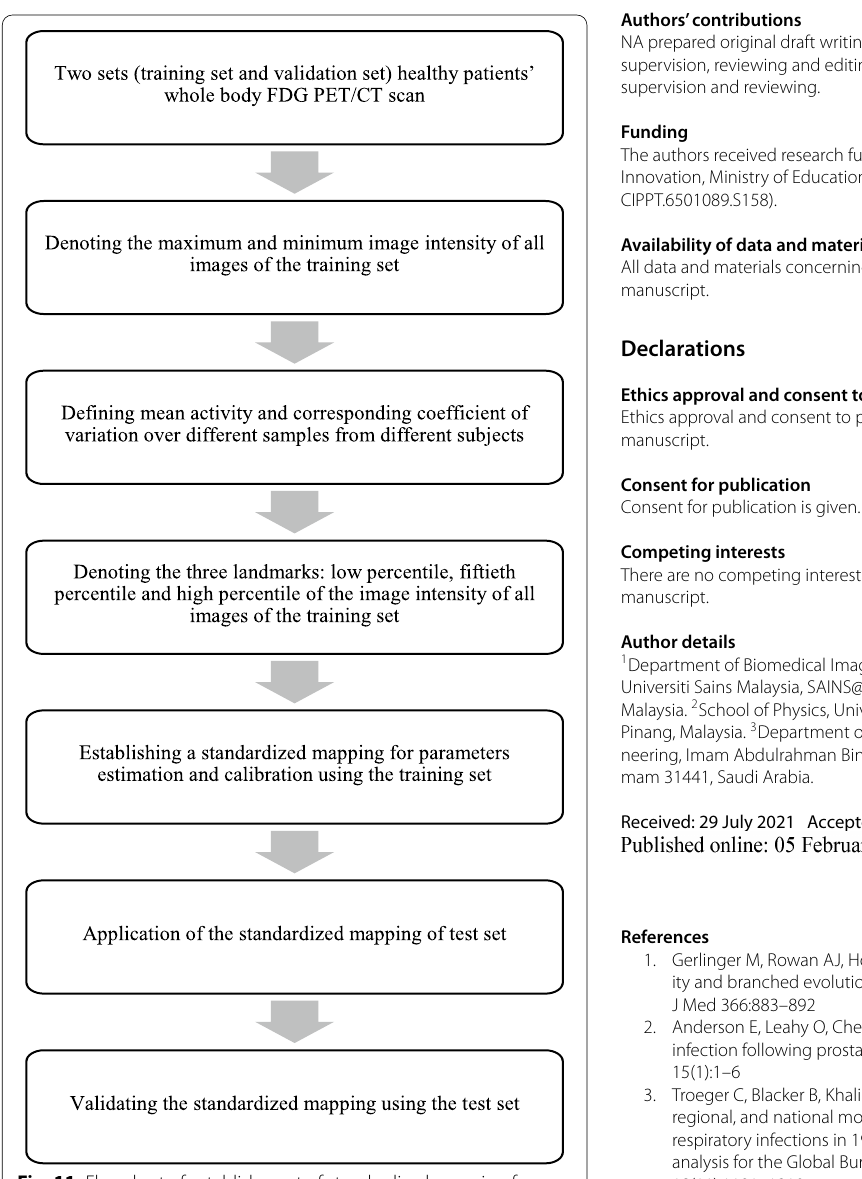
Fig. 11 Flowchart of establishment of standardised mapping for whole-body FDG PET/CT scan study by Mortazi et al.